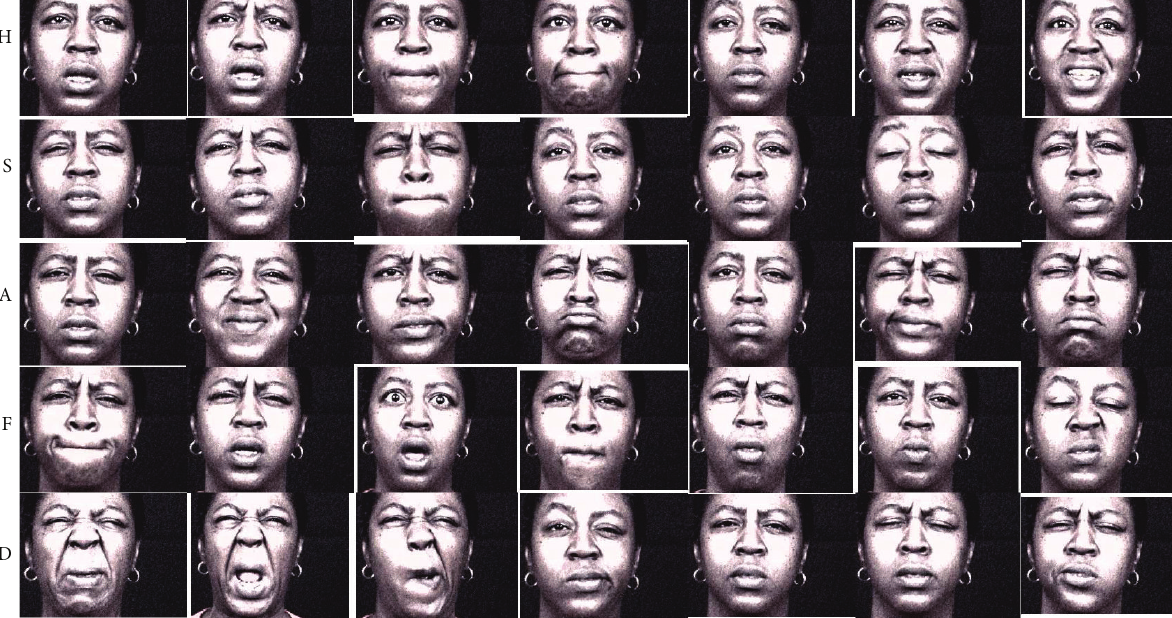
Figure 3: Sample videos of a subject with high ambiguity and low distinctiveness . High ambiguity and low distinctiveness appear as inappropriate facial expressions, due to the lack of consistent patterns within each emotion and the overlap of patterns across